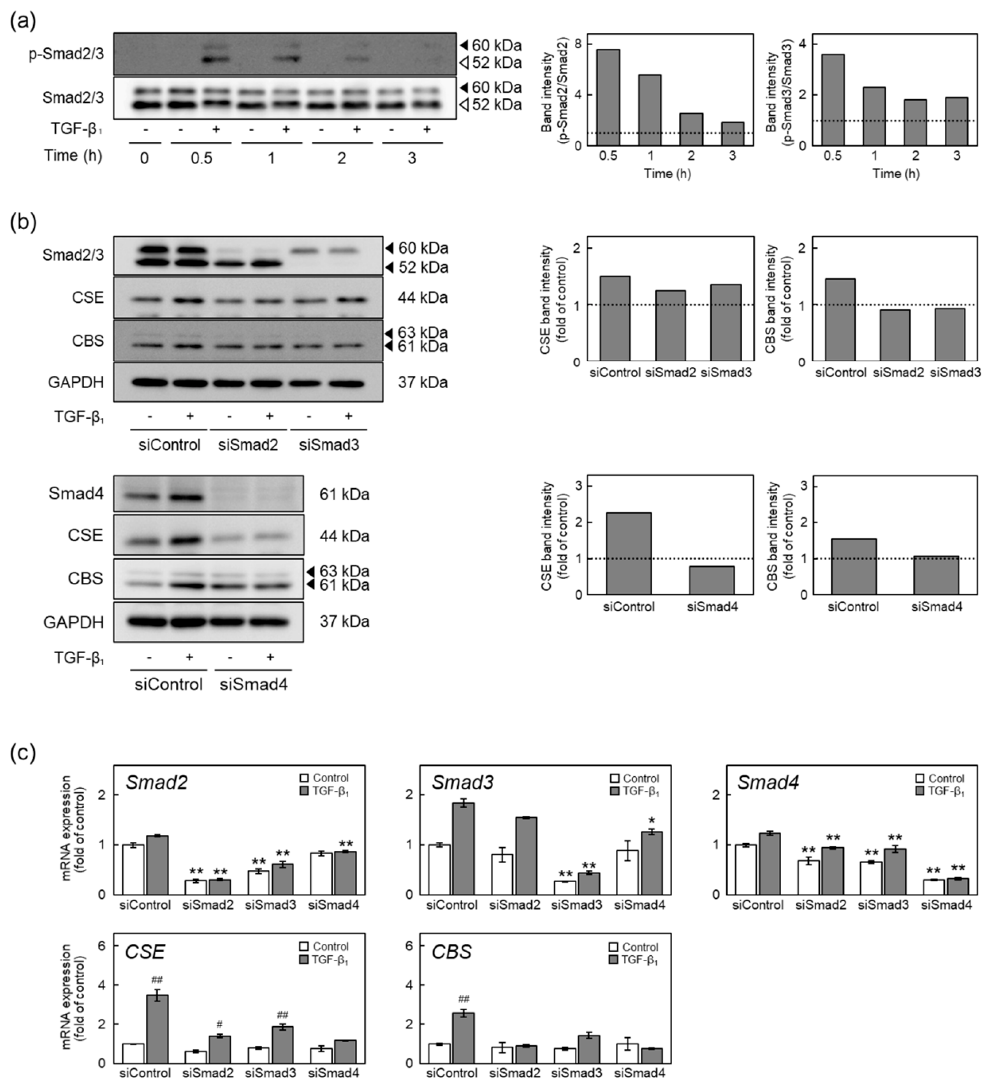
Figure 5. Involvement of Smad2/3/4 in the upregulation of CSE and CBS expression by TGF- β 1 in vascular endothelial cells. ( a ) Phosphorylation of Smad2/3 in vascular endothelial cells treated with TGF- β 1 . Confluent cultures of vascular endothelial cells were treated with TGF- β 1 (10 ng/mL) for 0.5, 1, 2, or 3 h. The arrowheads indicate Smad2 protein (solid arrowheads) and Smad3 protein (open arrowheads). Quantification of band intensities of phospho-Smad2/3 and Smad2/3 (right panels). The data are representative of two independent experiments. ( b ) Levels of Smad2, Smad3, Smad4, CSE, and CBS proteins in Smad2-, Smad3-, or Smad4-suppressed vascular endothelial cells treated with TGF- β 1 . Subconfluent cultures of vascular endothelial cells were transfected with either Smad2, Smad3, or Smad4 siRNA for 4 h and then treated with TGF- β 1 (10 ng/mL) for 24 h. The arrowheads indicate the corresponding protein. Quantification of band intensities of CSE and CBS (right panels). The data are representative of two independent experiments. ( c ) Expression of Smad2, Smad3, Smad4, CSE, and CBS mRNAs in Smad2-, Smad3-, or Smad4-suppressed vascular endothelial cells treated with TGF- β 1 . Subconfluent cultures of vascular endothelial cells were transfected with either Smad2, Smad3, or Smad4 siRNA for 4 h and then treated with TGF- β 1 (10 ng/mL) for 12 h. Values are means ± S.E. of three independent samples. The data were analyzed using one-way ANOVA, followed by Tukey–Kramer’s test. Significantly different from the corresponding siControl, * p < 0.05; ** p < 0.01. Significantly different from the corresponding control, # p < 0.05; ## p <